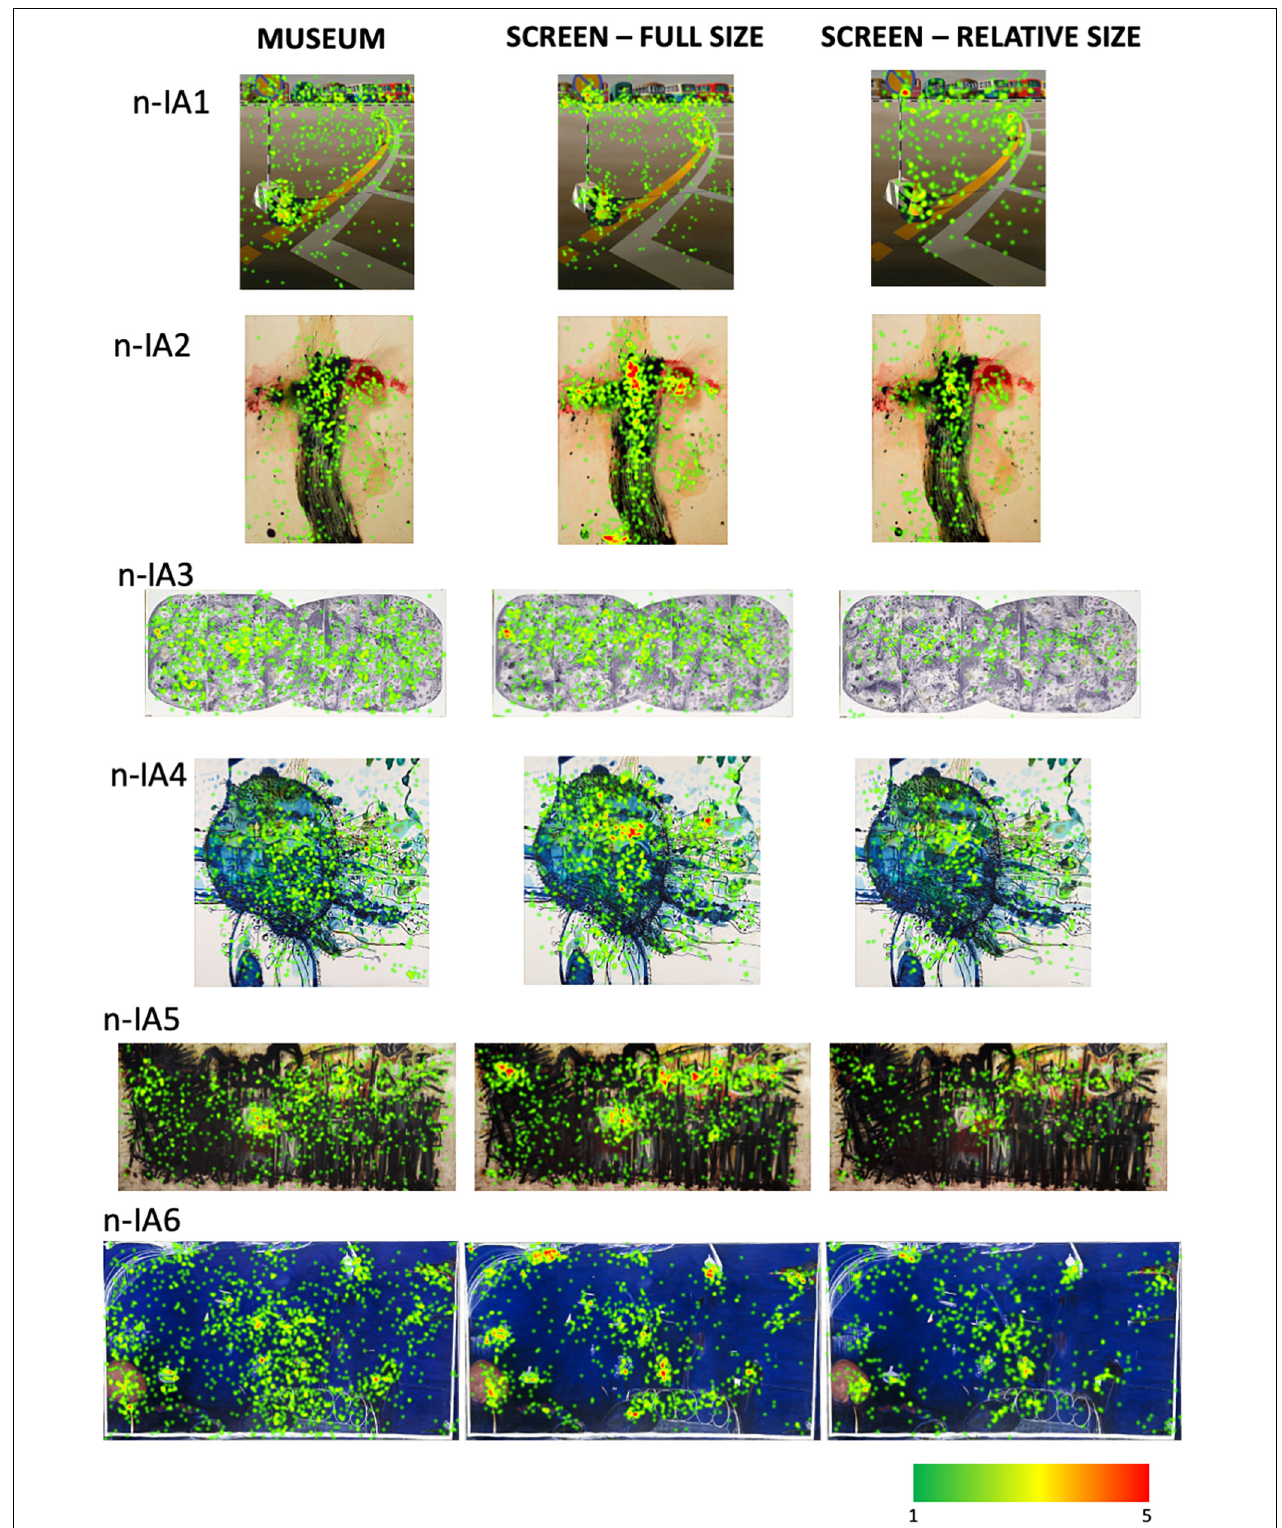
FIGURE 10 | The heatmaps of total fixation counts for the non-Indigenous Australian paintings in the three viewing conditions. See Supplementary Material for bigger, higher-quality versions of these heatmaps.